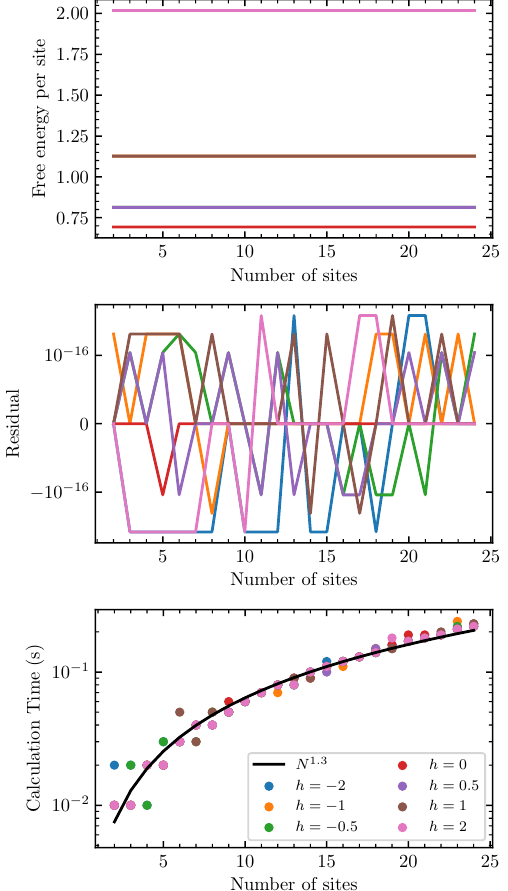
Figure 21: The free energy per site from PyTNR (top), residuals (middle) and run time (bottom) for the 1D Ising model with nearest-neighbor interactions is shown as a function of the number of sites for a variety of on-site energies h